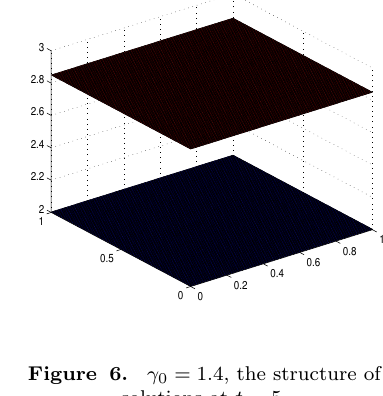
Figure 5. γ 0 = 1 . 4, the structure of solutions at t = 0.